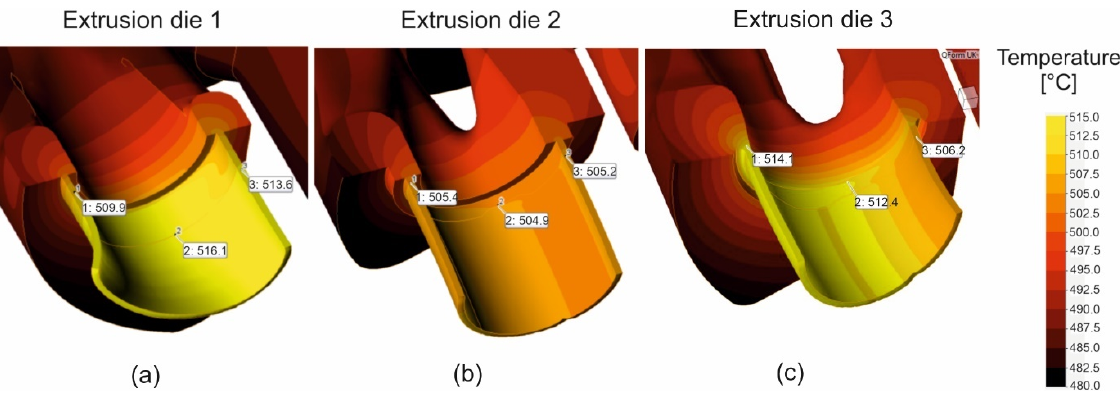
Figure 6. Distribution of metal velocity during extrusion of tubes of Ø50 × 2 mm from 7021 alumin- ium alloy through porthole dies of different geometry—die 1 a ), die 2 b ) and die 3 c ).